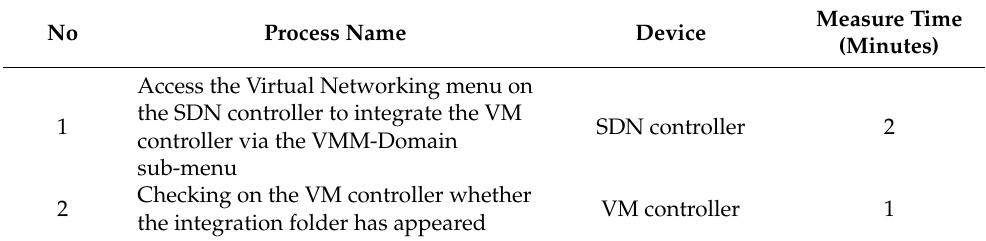
Table 7. New VM controller integration measurement time via SDN controller.